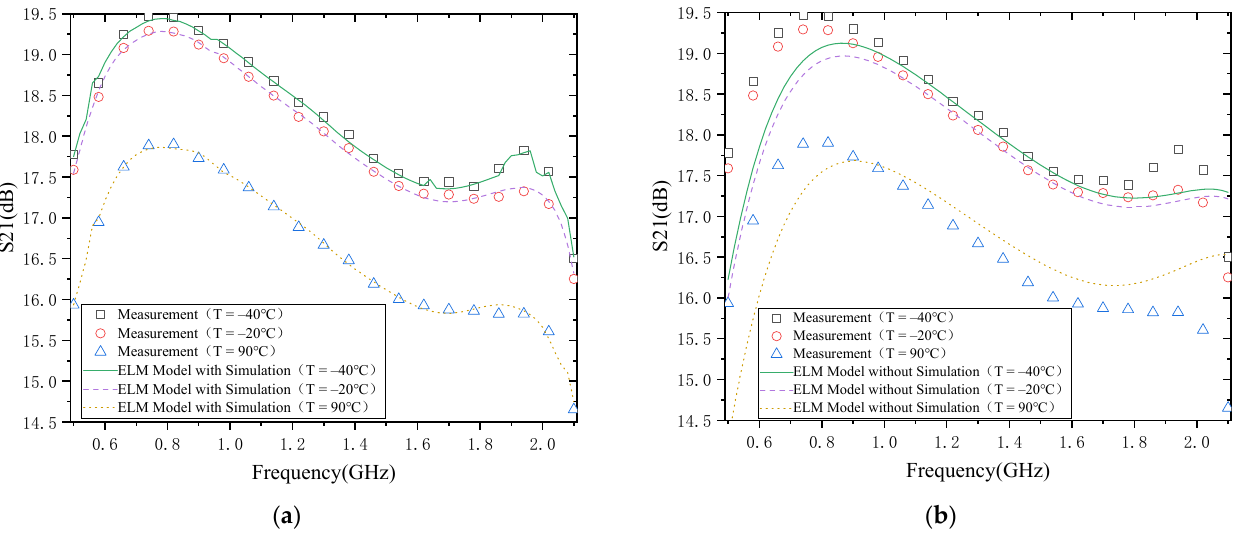
Figure 5. S21: ( a ) with simulation; ( b ) without simulation.